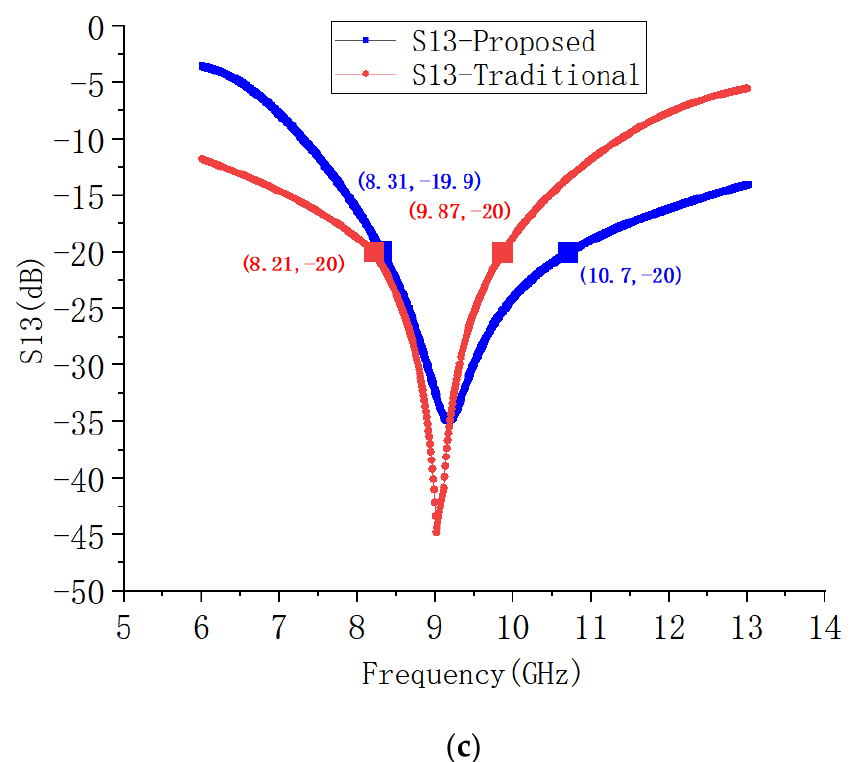
Figure 8. The results of the EM simulation for the S parameters of the proposed bias circuit and the traditional bias circuit. ( a ) S12. ( b ) S11. ( c ) S13. The parasitic inductance of the traditional bias circuit and the proposed bias circuit is simulated by ANSYS. The simulation’s structural diagram is presented in Figure 9. Besides the bias circuit, the soldering pad of the stability circuit, the solder, and the connecting line between the bias circuit and the modulated power-supply circuit are also included to make the simulation results as realistic as possible.